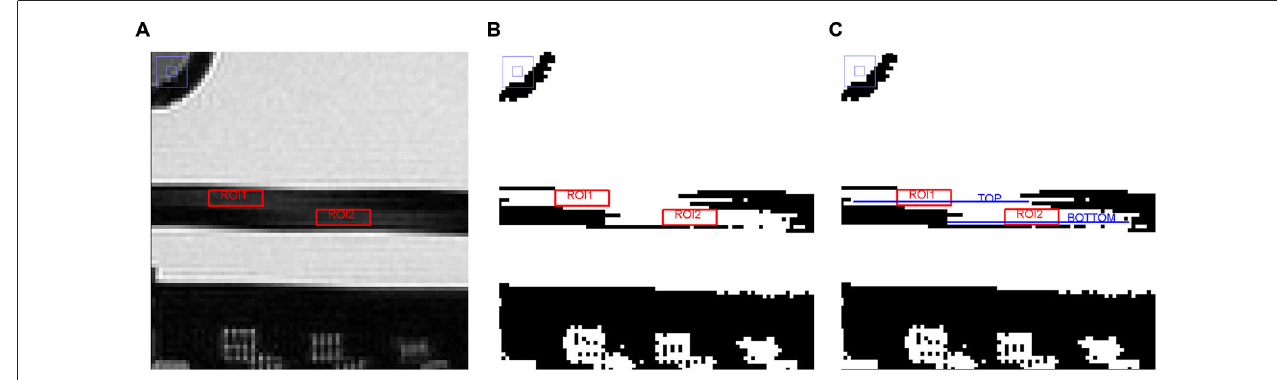
FIGURE 5 | Different steps adopted in the image analysis on slice 5 for the “Slice thickness accuracy test” (see the text for further details). (A) Magnified region of slice 5 showing slice thickness signal ramps with ROIs placed for measuring average signal in the ramps, (B) Slice 5 after setting the new display window level value, and (C) Slice 5 with TOP and BOTTOM elements represented by linear